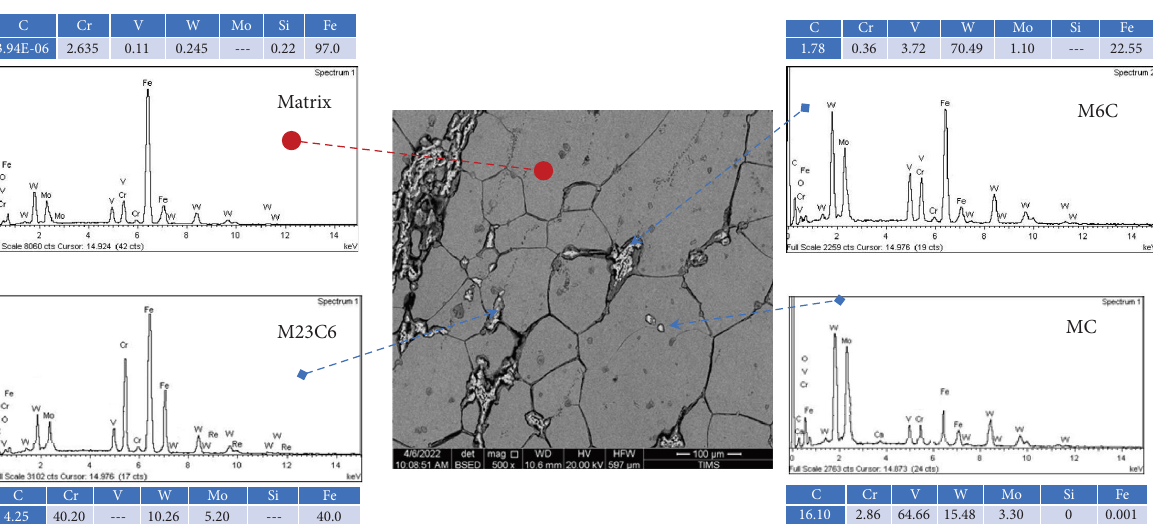
Figure 12: Vanadium-modifed high-speed tool